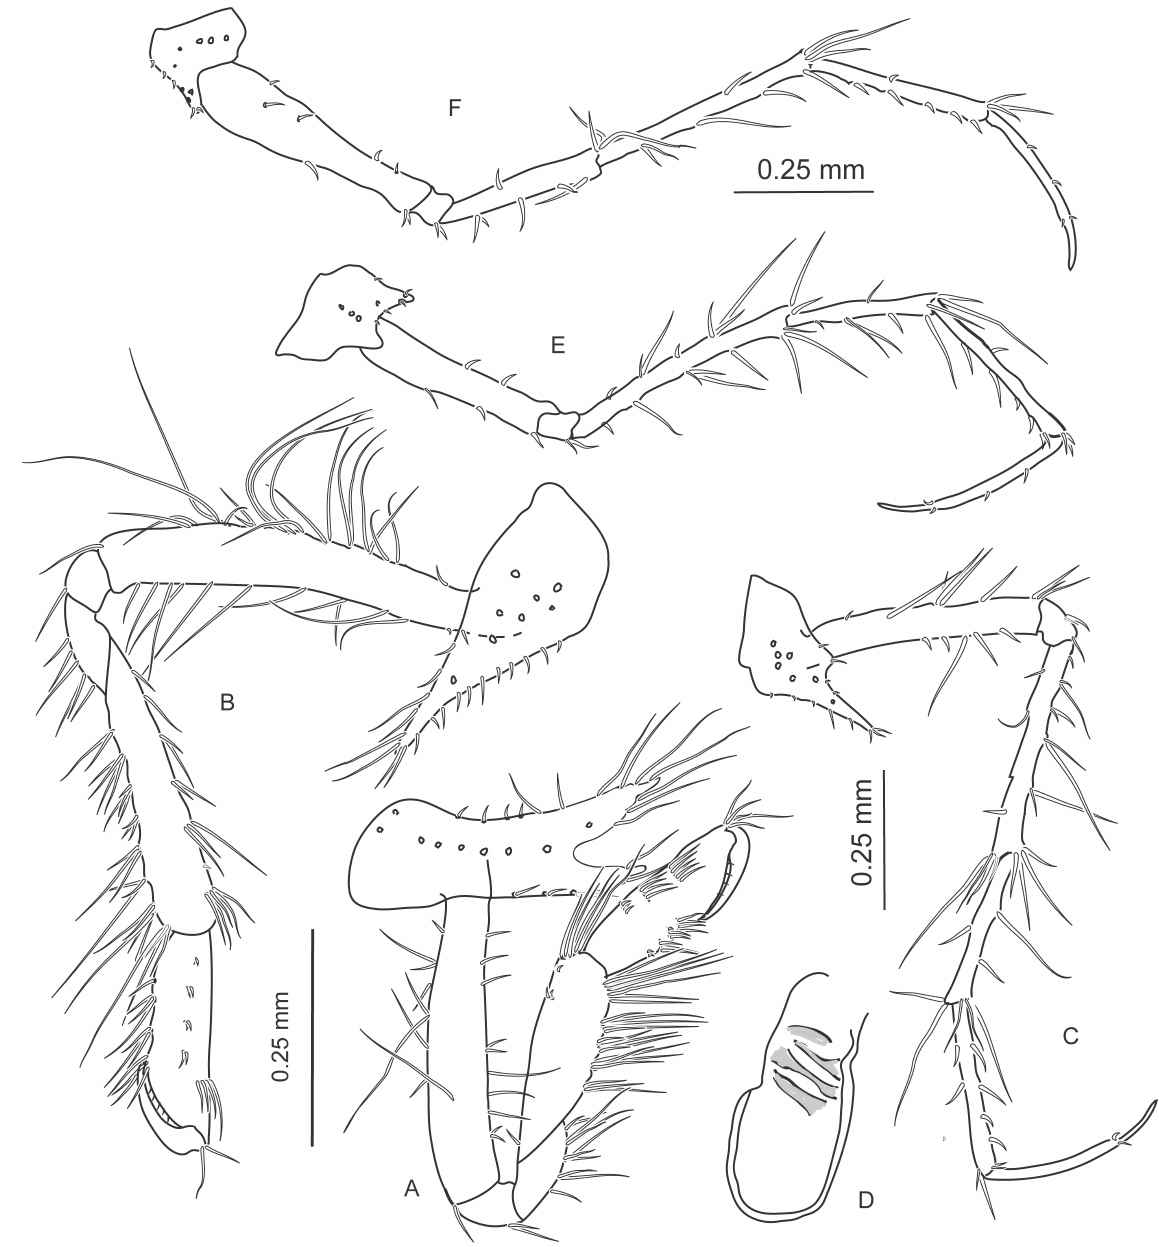
Fig. 10. Lepechinella schellenberg i Stephensen, 1944 , lectotype, ♀. A . Right Gn1. B . Right Gn2. C . Left P3. D . Gill of P5. E . Right P4. F .